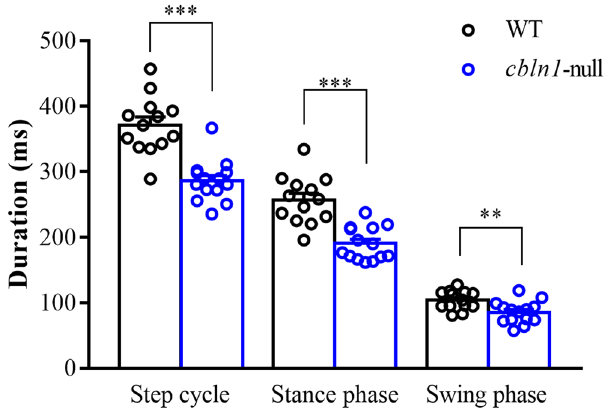
Figure 1. Average step cycle duration. The histograms display average durations of overall step cycle, stance, and swing phases in wild-type (WT) and cbln1 -null mice. ** p < 0.01; *** p <